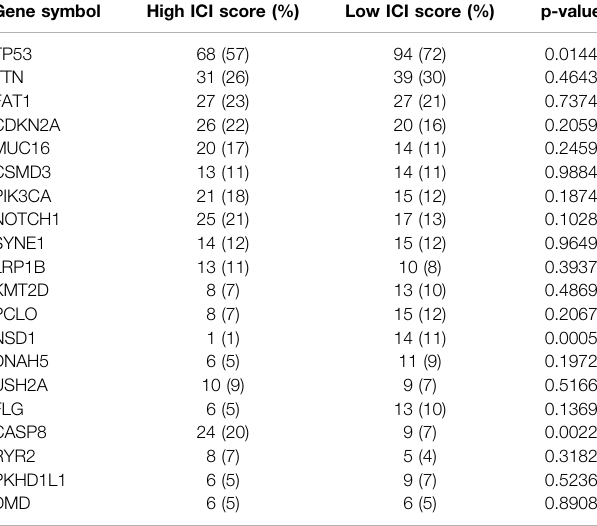
TABLE 2 | Association of TIME scores with somatic variants. Gene